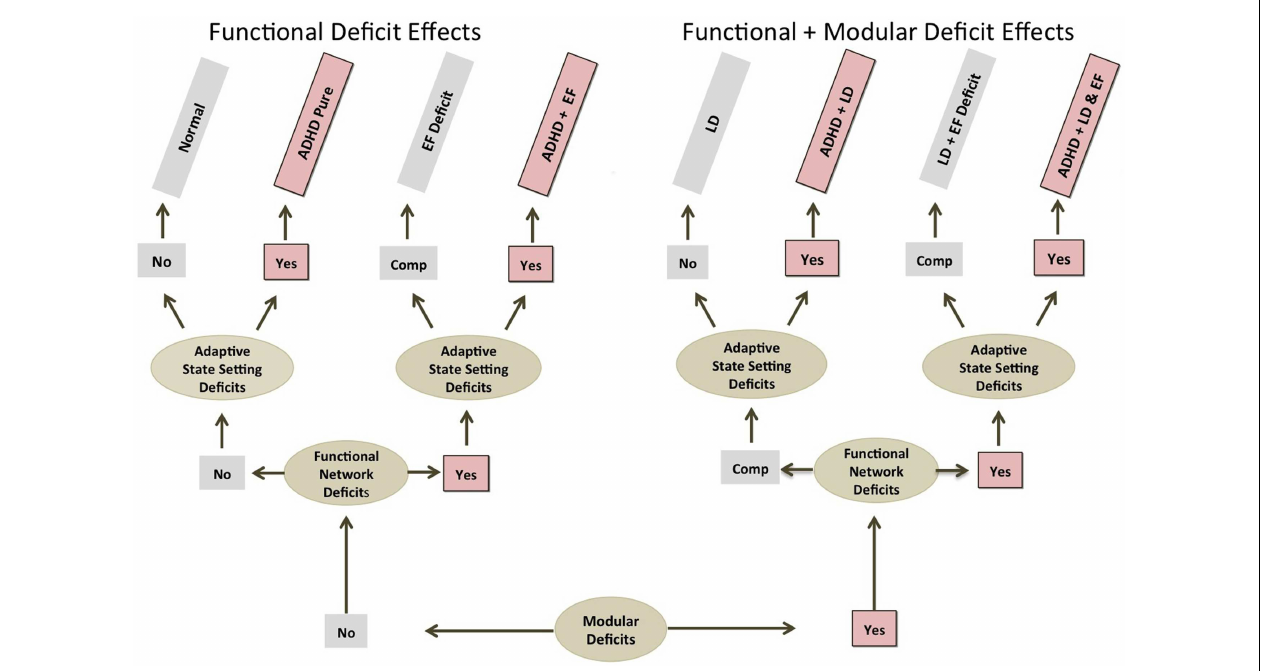
sources, all ADHD producing etiological paths involve impairment at the adaptive state setting level. EF, executive function; LD, learning disorder; Comp.,